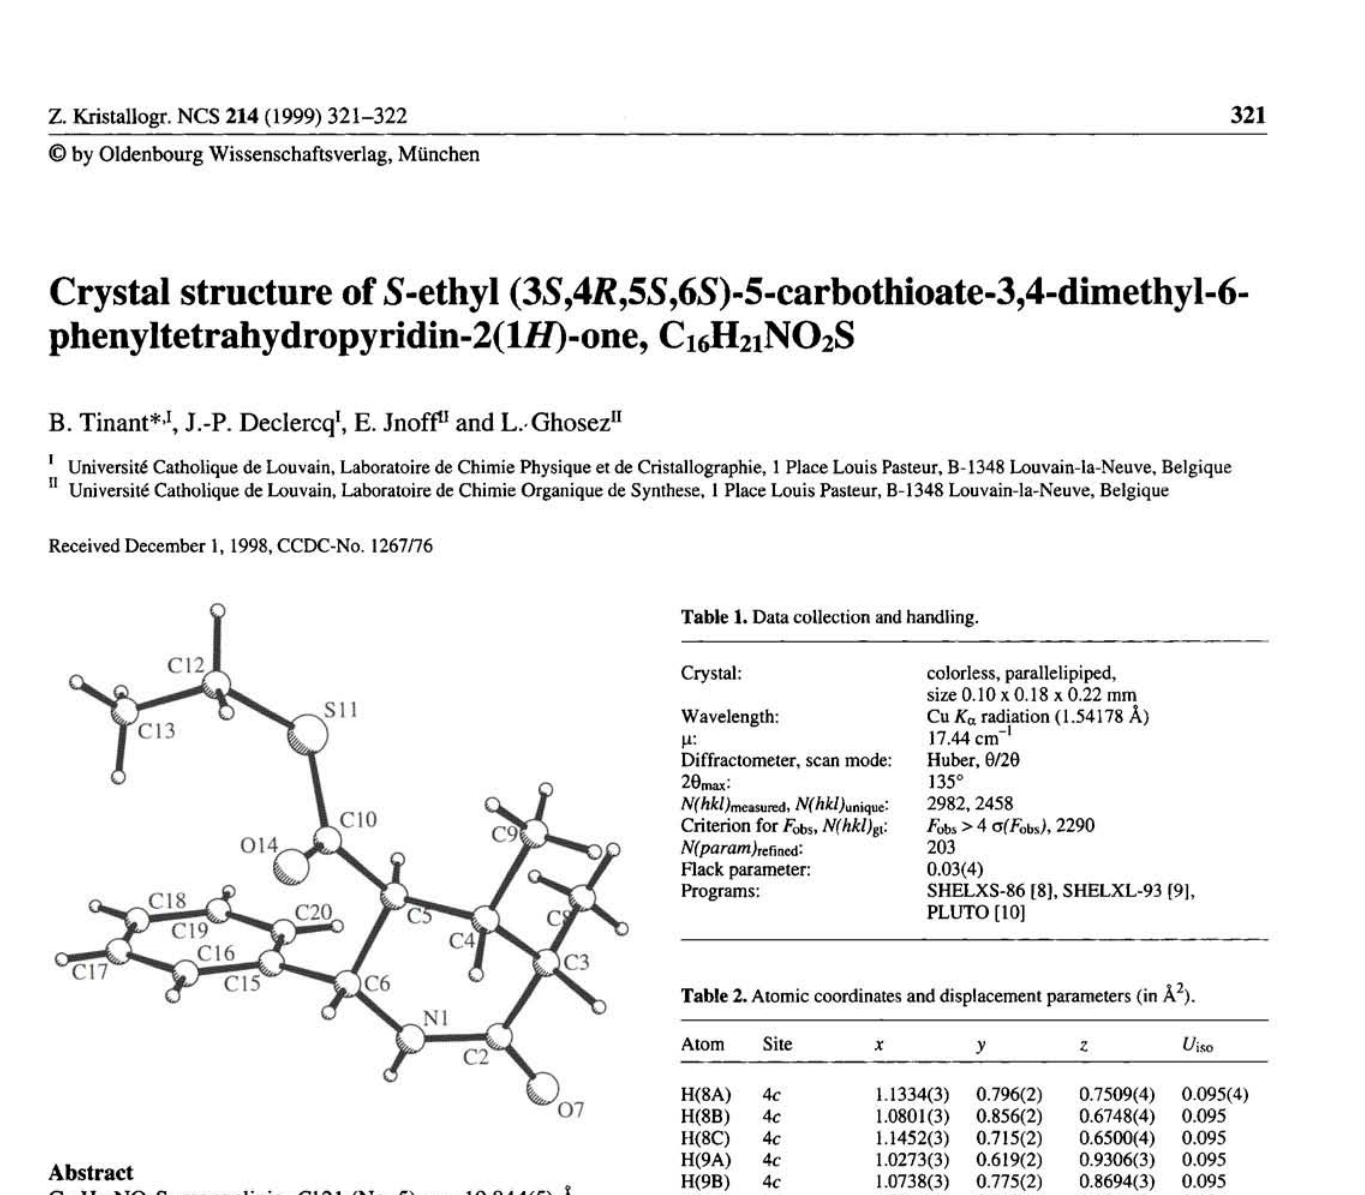
Table 2. Atomic coordinates and displacement parameters (in À 2